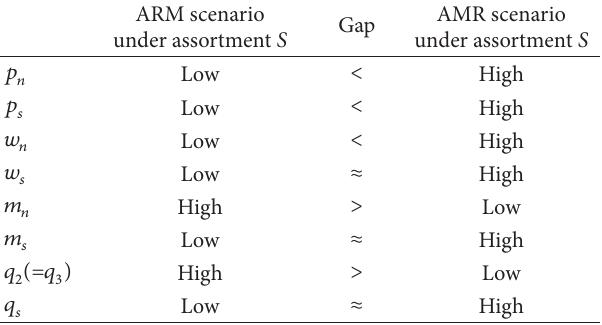
Table 3: Comparison between the ARM scenario under assortment F and the AMR scenario under assortment S , if 𝛽 is